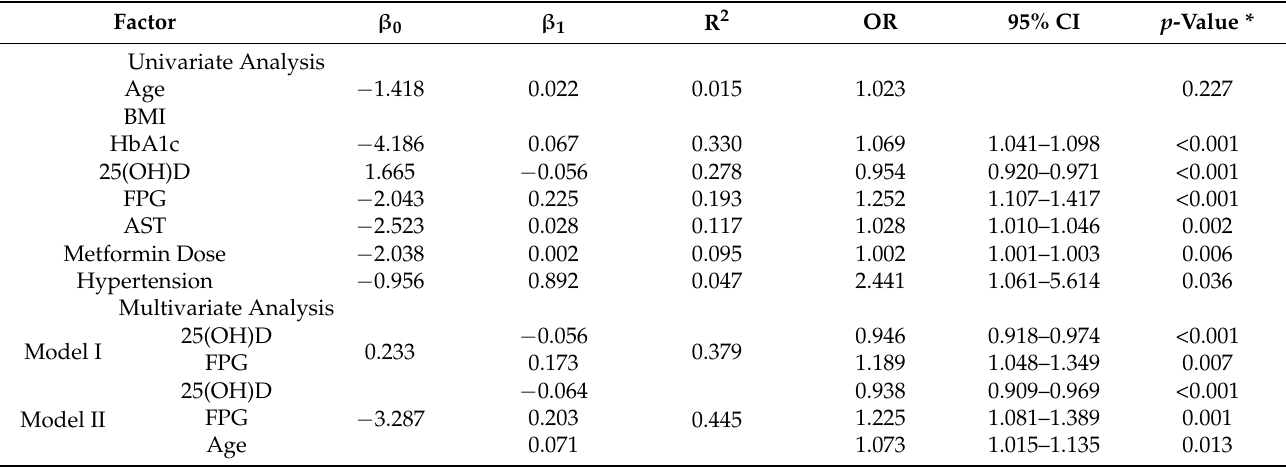
Table 4. Uni- and Multivariate Logistic Regression Analysis to Evaluate the Influence of Different Pre-Surgery Factors on T2DM Remission at 12